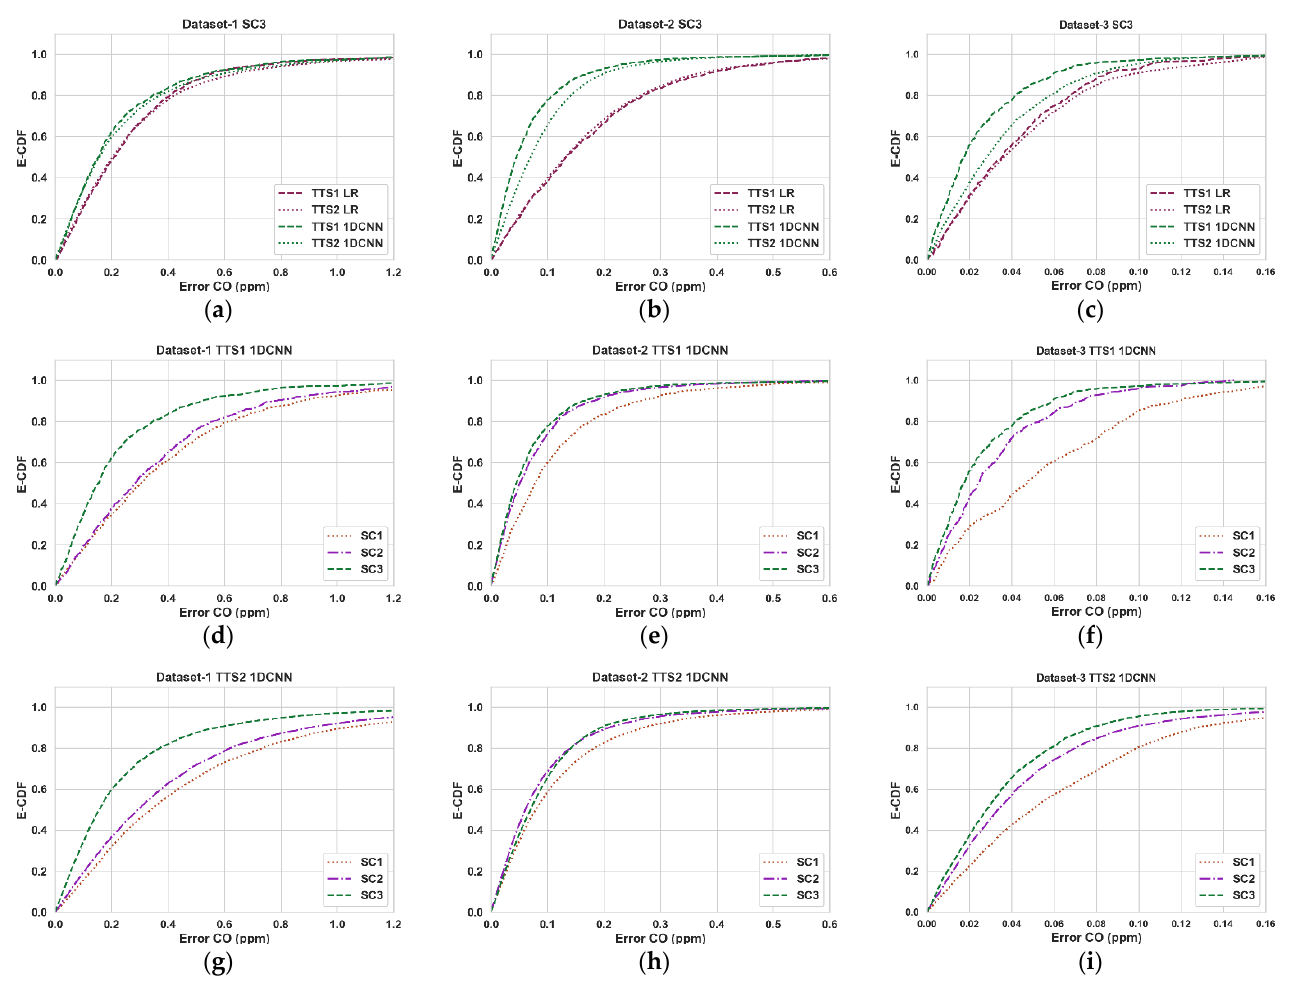
Figure 5. Empirical CDF plots of calibration error for 1DCNN. ( a – c ) Compare the CDF of error of the 1DCNN algorithm to the same of linear regression for both 90/10 (TTS1) and 20/80 (TTS2) splits for scenario 3 (with all available input parameters) for datasets 1 – 3. ( d – f ) Show how the CDF of error of the 1DCNN algorithm improves from scenarios 1 – 3 for TTS1. ( g – i ) Show how the CDF of error of the 1DCNN algorithm improves from scenarios 1 – 3 for TTS2.